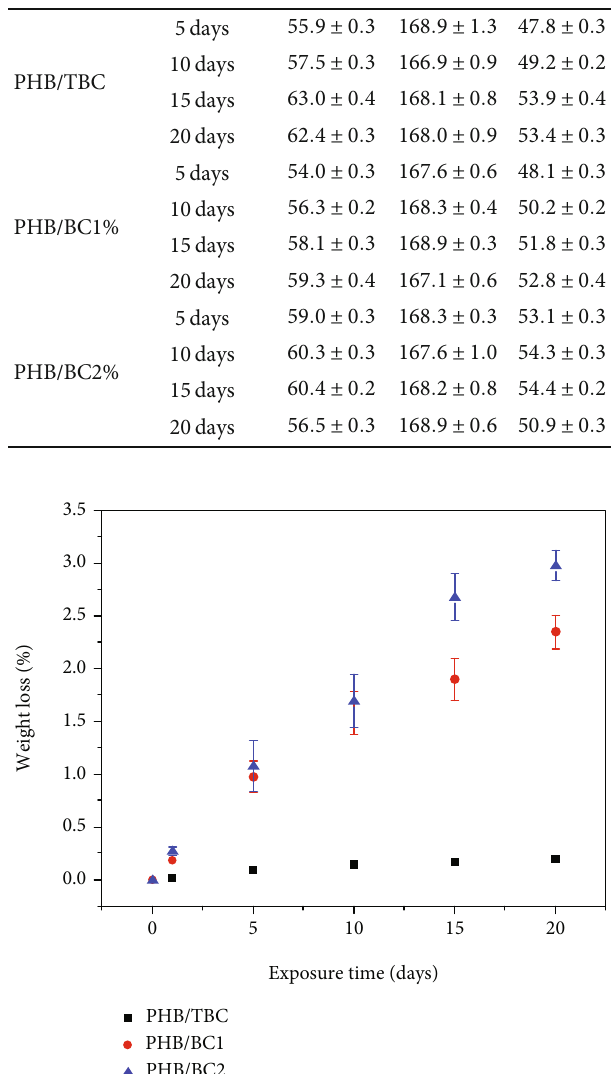
Figure 4: Weight loss of plasticized PHB sample and its biocomposites during 20 days of exposure to PBS